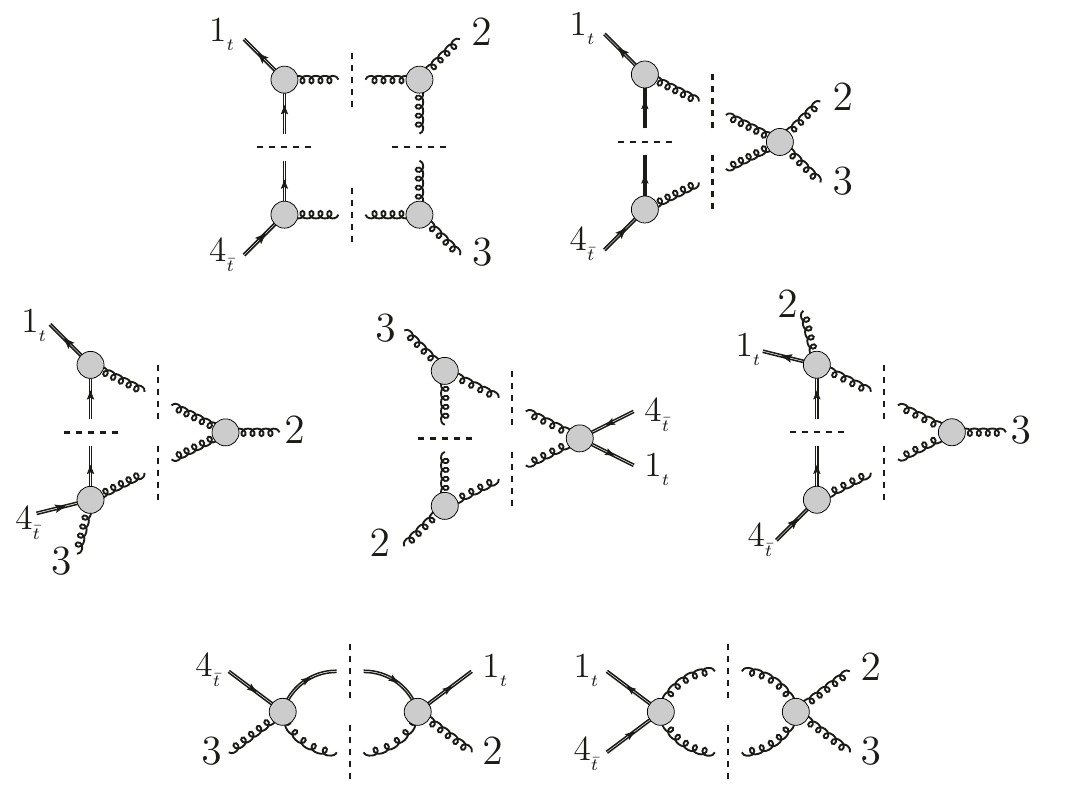
. Double lines represent massive t ; 2 ; 3 ; 4 (cid:22) t )